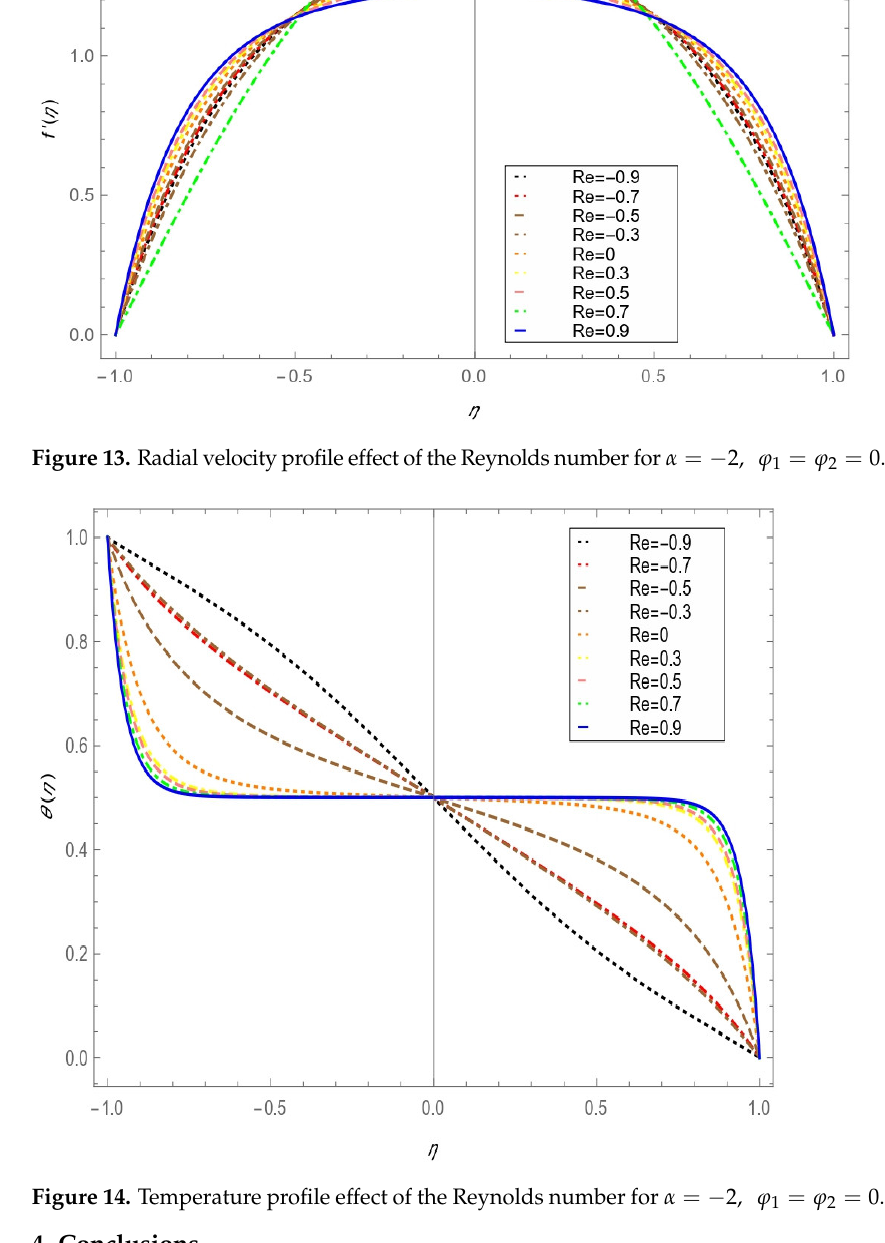
Figure 14. Temperature profile effect of the Reynolds number for α = − 2, ϕ 1 = ϕ 2 = 0.02, Pr = 6.2.